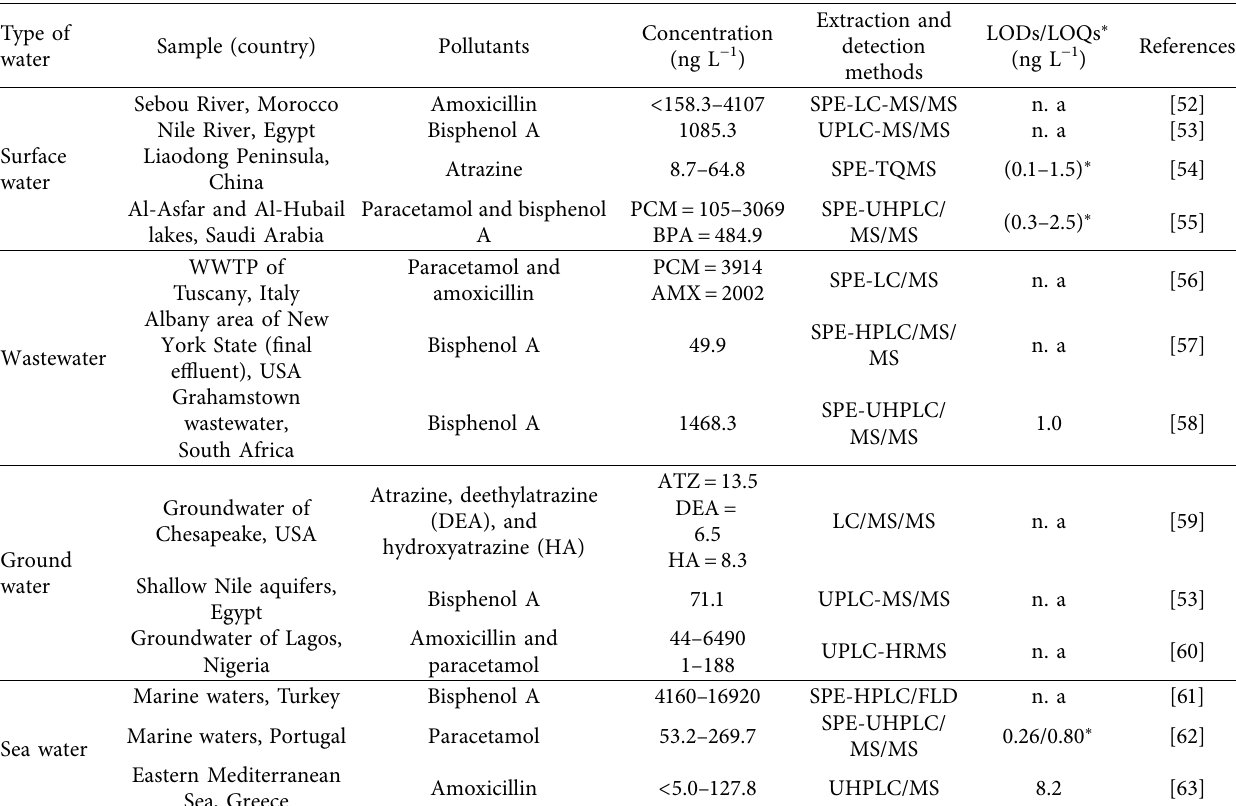
Table 2: Occurrence of emerging pollutants in the aquatic environment.